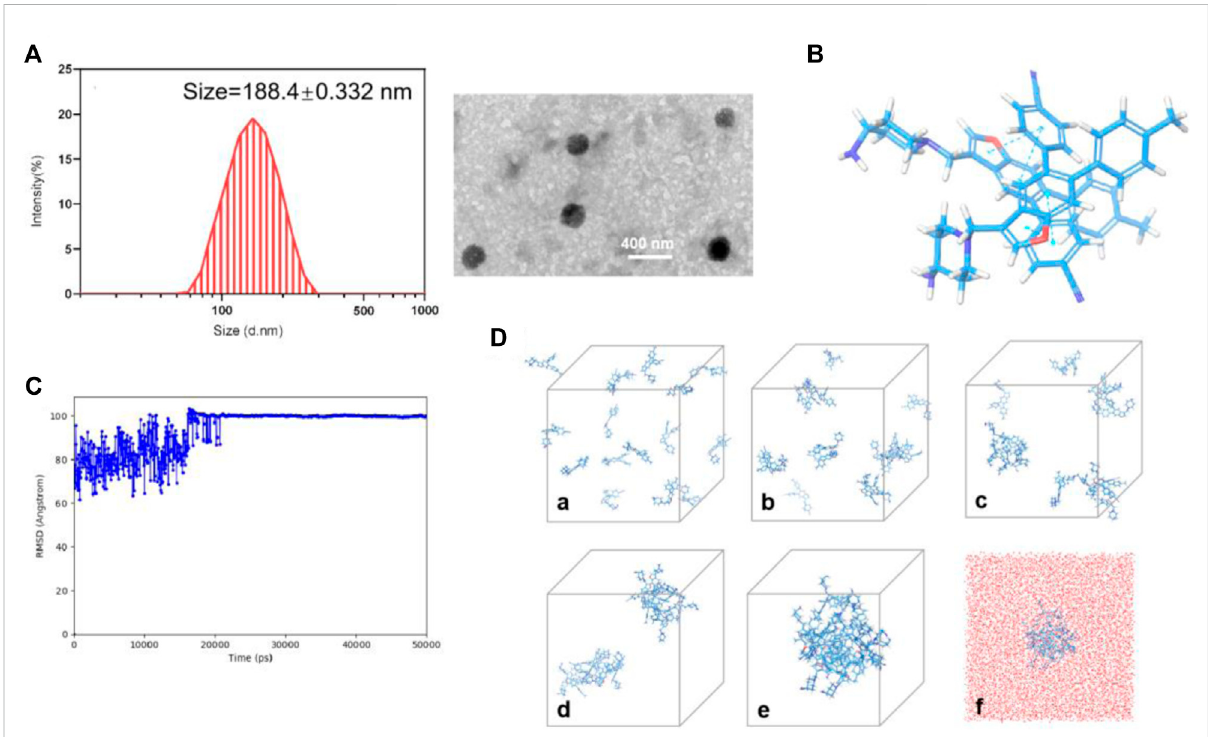
FIGURE 4 (A) Particle size distribution and TEM images of PEGylated 17i nanoassemblies. (B) Docking diagram of the assembly mechanism of compound 17i . (C) Root Mean Square Deviation (RMSD) values of the nanoassembly system. (D) The aggregation process of 17i in water at (a) 0 ns, (b) 2.5 ns,